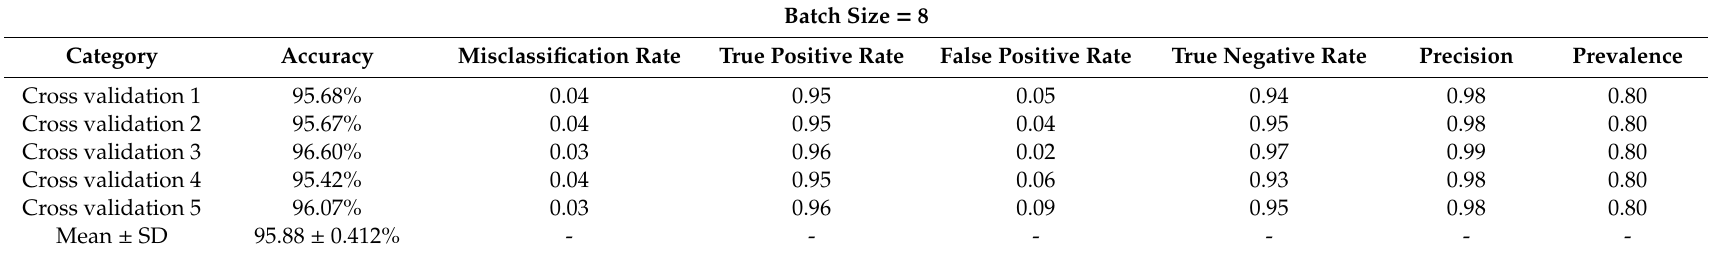
Table 1. Accuracy, misclassification rate, true positive rate, false positive rate, true negative rate, precision, prevalence, and mean and standard deviation of accuracy for a batch size of 8.